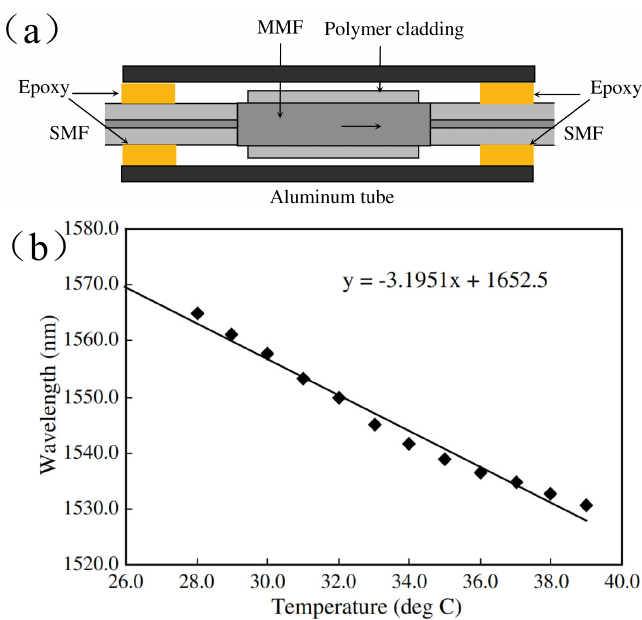
Figure 7. Schematic diagram of the proposed sensing system [47]. Reprinted with permission from Ref. [47]. Copyright 2008 Elsvier Science and Technology